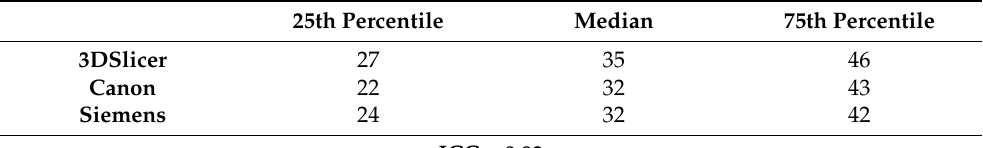
Figure 10. Statistical description of the three software. This box plot scheme shows that 3DSlicer delivers a higher value in the median of the measures assessed. Table 3. Summary of descriptive statistical calculation within the three software. The ICC index returned a value of the reliability of 0.92 (CI 0.90–0.94), indicating an excellent one within the three software employed. ICC = Intraclass Correlation Coefficient, CI = Confidence Interval.